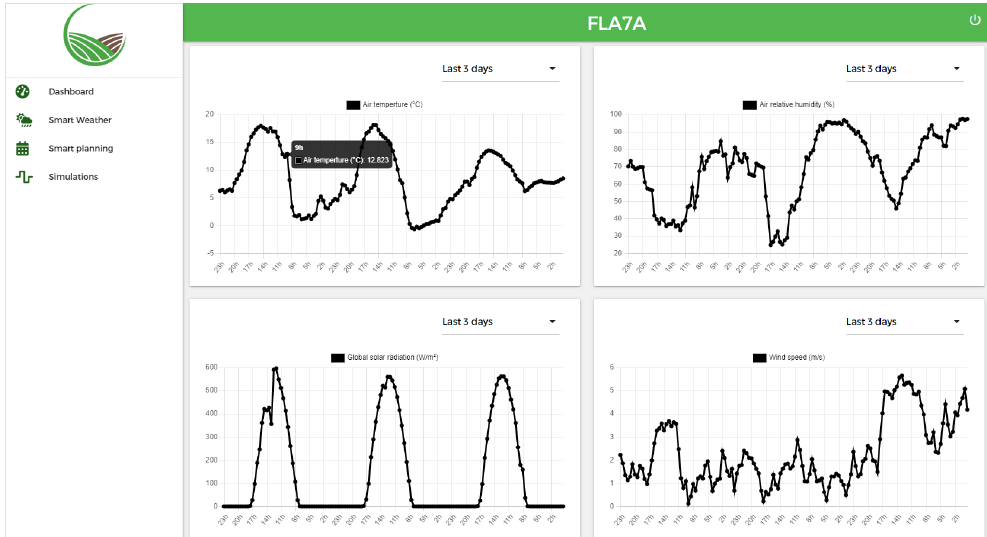
Figure 14. A screenshot of the platform’s real-time weather time series visualization service. The black dots represent the original measurements, while the black line represents the linear interpolation of the